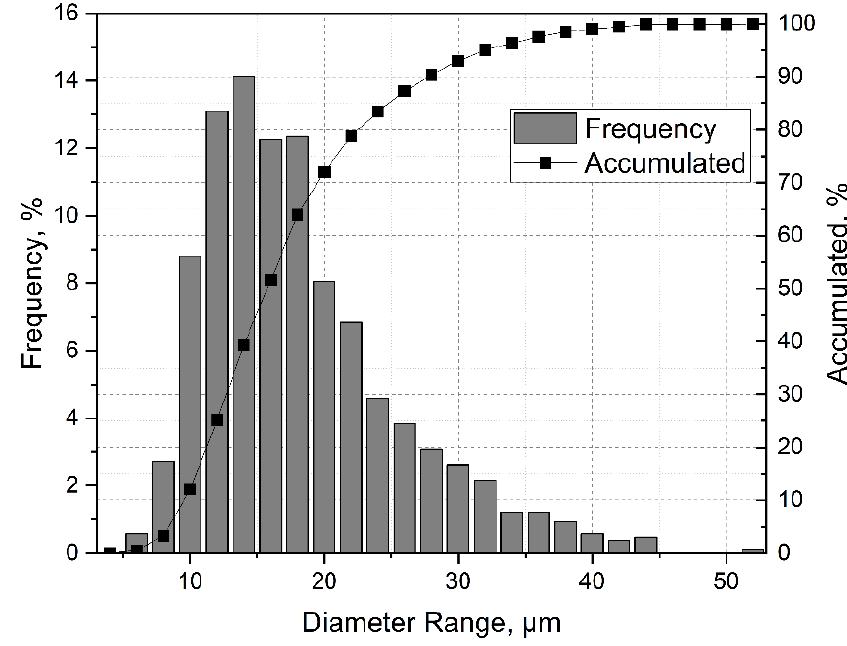
Figure 2. Distribution of powder particle sizes.